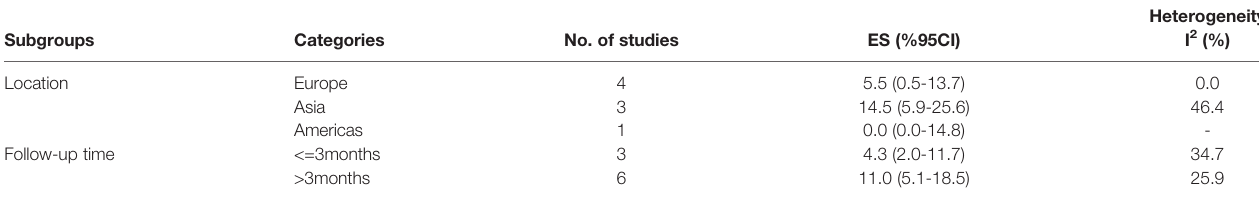
TABLE 5 | Subgroup analyses for mortality in ADEM adults.